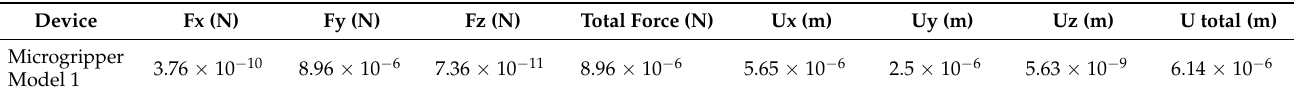
Figure 11. Microgripper Model 1. ( a ) Temperature distribution, and ( b ) displacement at 2 V.